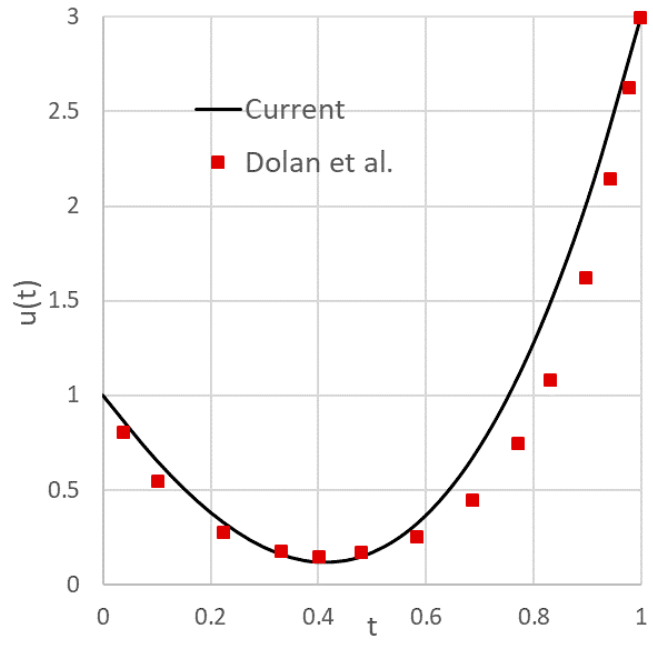
Figure 5. Optimal u ( t ) computed using 3rd order parametrization for problem 3.1. Reported values by Dolan et al. are also shown.